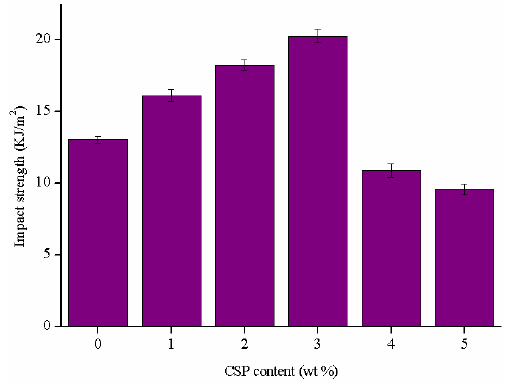
Figure 8. Impact strength of the epoxy/ATHBP thermosets modified with different contents of CSPs.